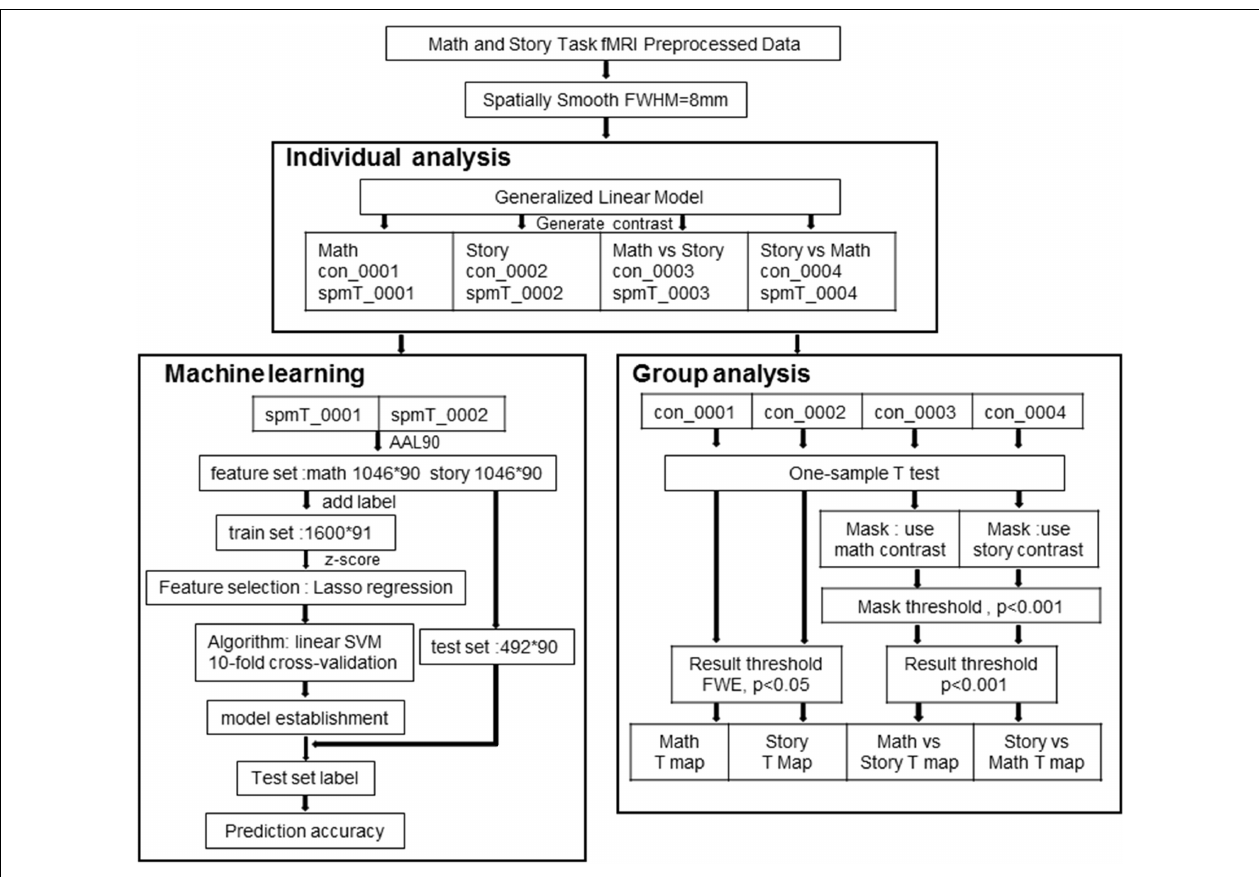
FIGURE 1 | Data processing flowchart for SPM and machine learning